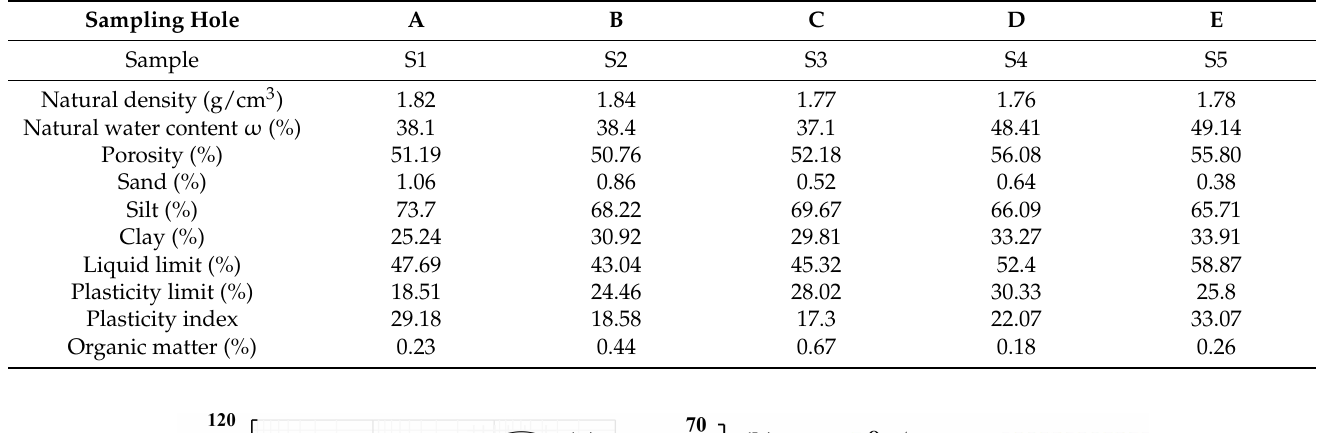
Table 1. Basic properties of natural soil.